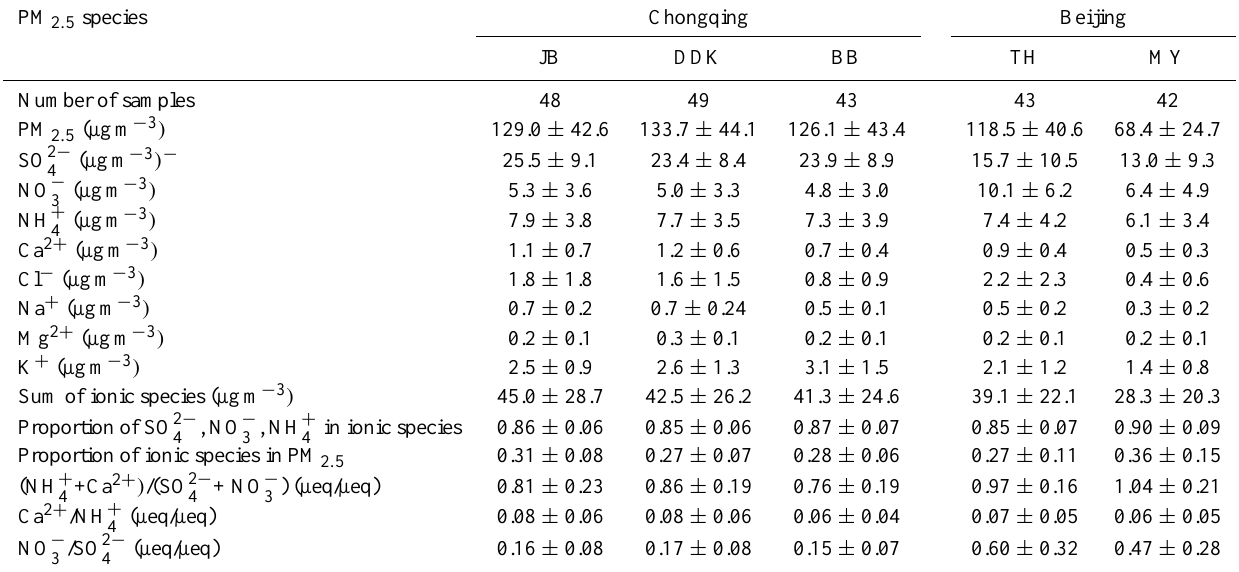
Table 1. Annual mass concentrations of PM 2 . 5 , its major ionic species and their equivalent ratios at Beijing and Chongqing from March 2005 to February